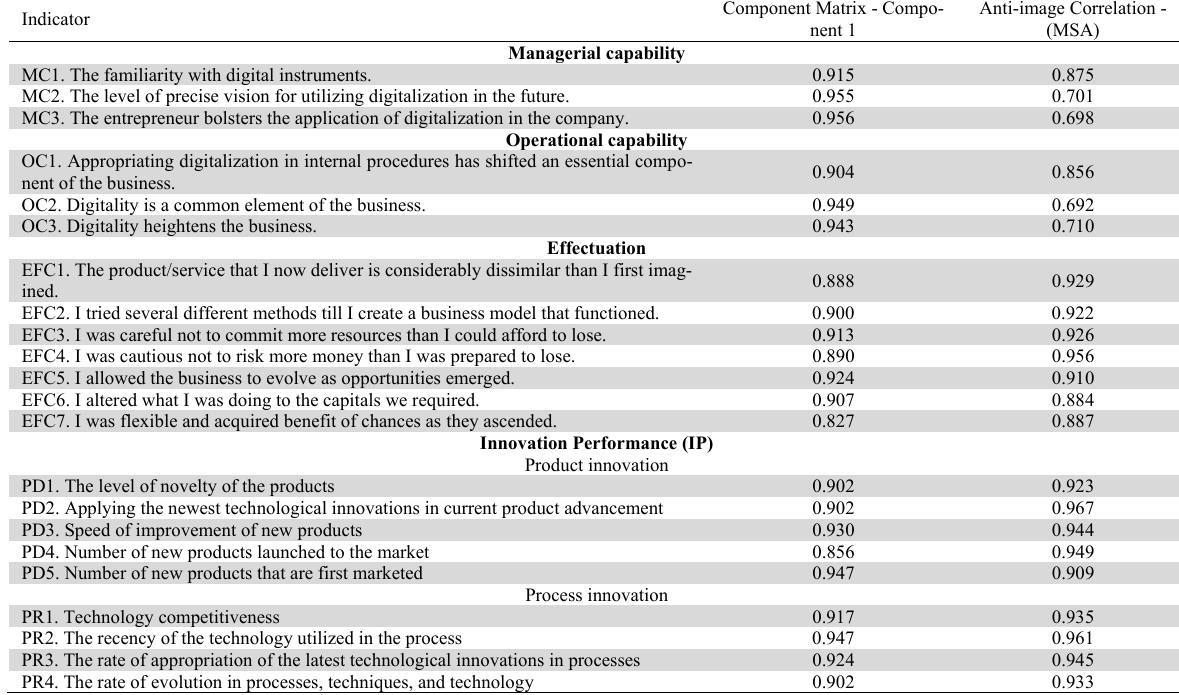
Validity and Reliability Test